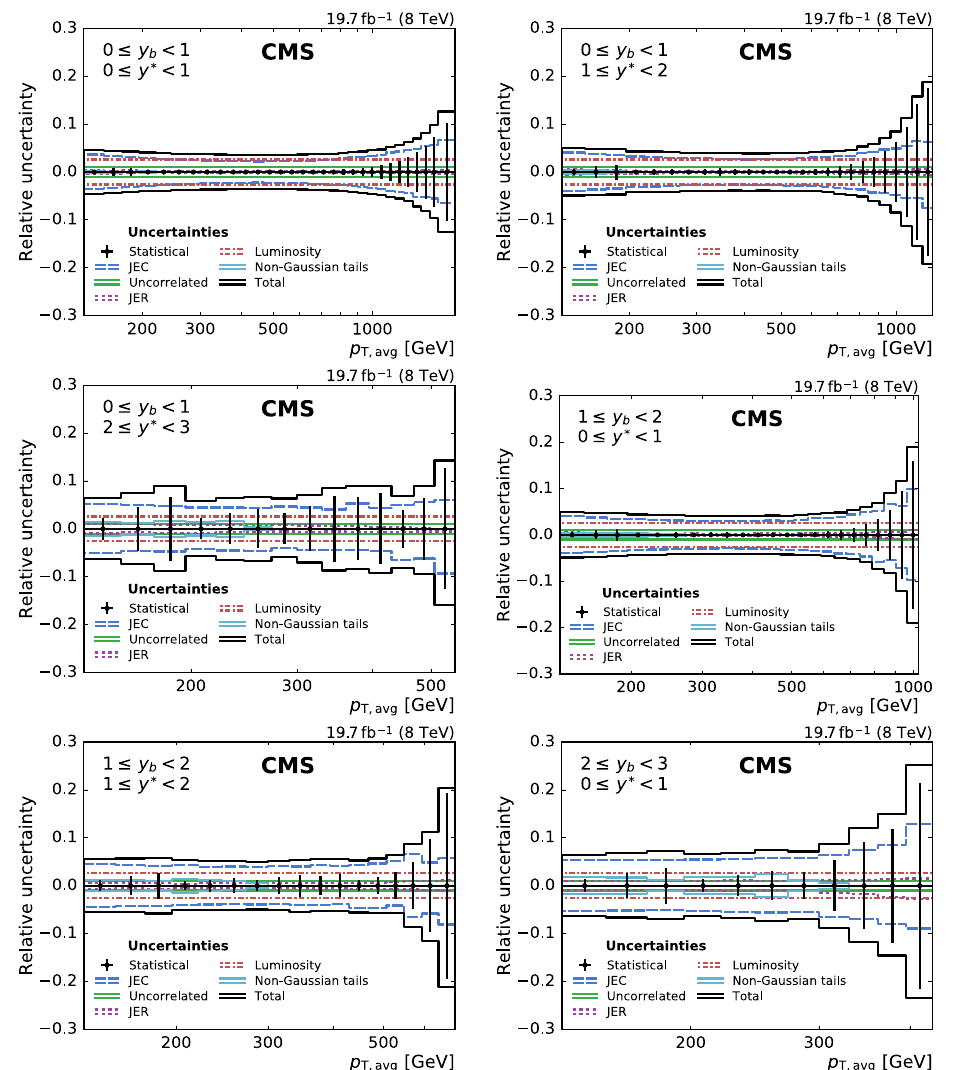
Fig. 3 Overview of all experimental uncertainties affecting the cross section measurement in six bins of y b and y ∗ . The error bars indicate the statistical uncertainty after unfolding. The different lines show the uncertainties resulting from jet energy corrections, jet energy resolu-